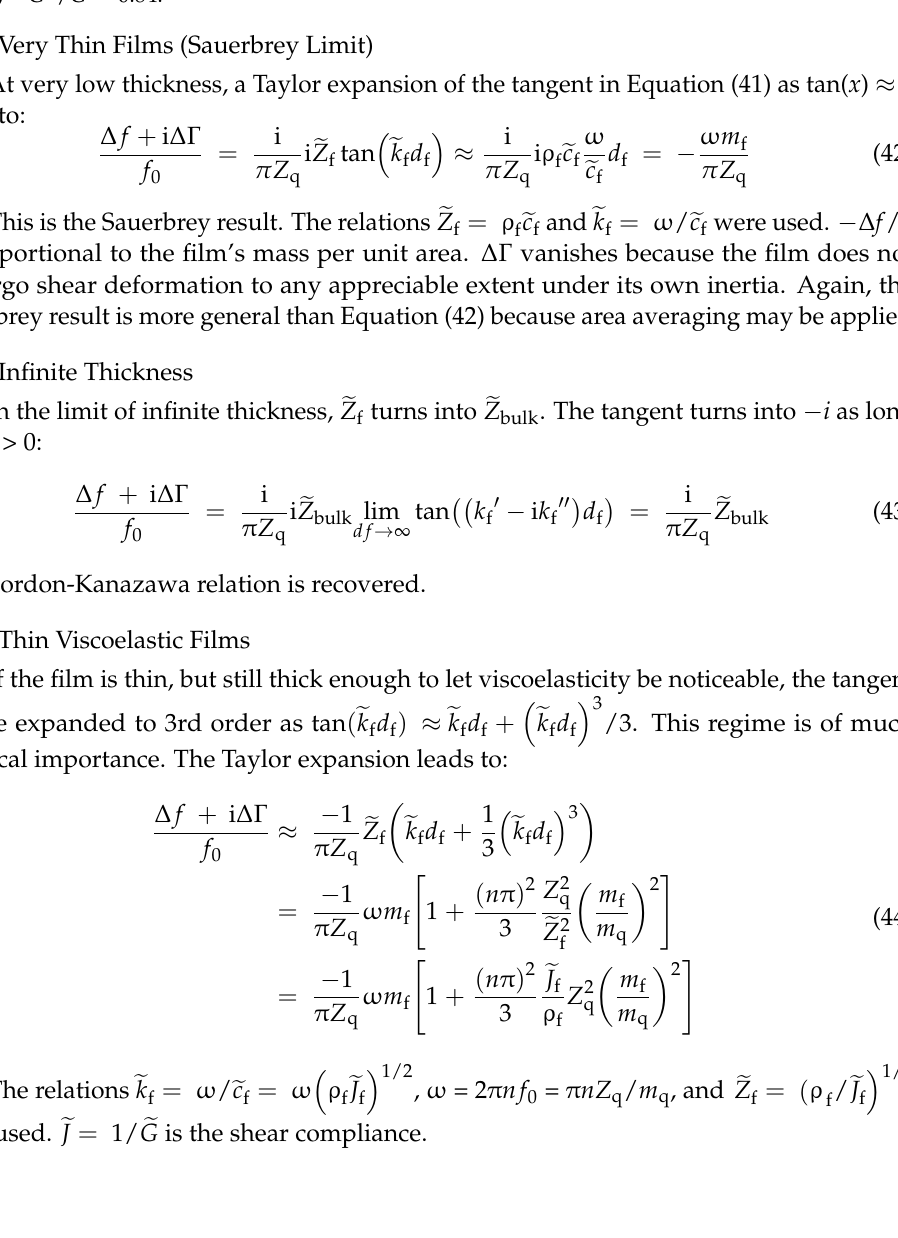
(cid:17) 1/2 / (cid:101) J f f